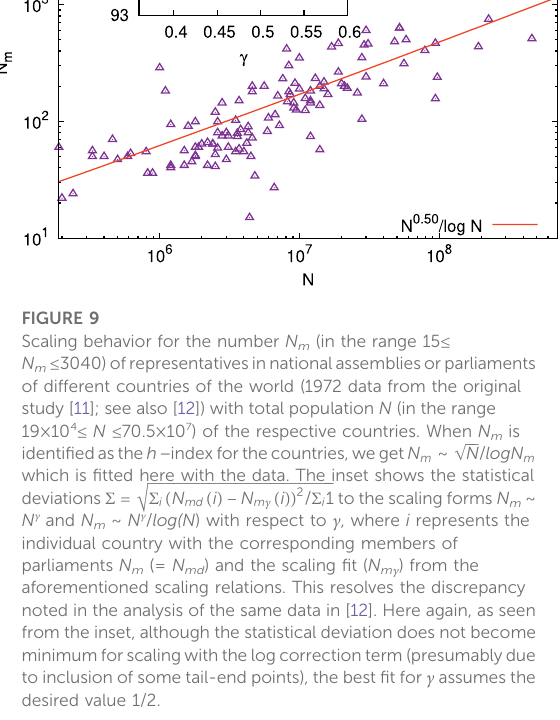
Figure 8A and to h ~